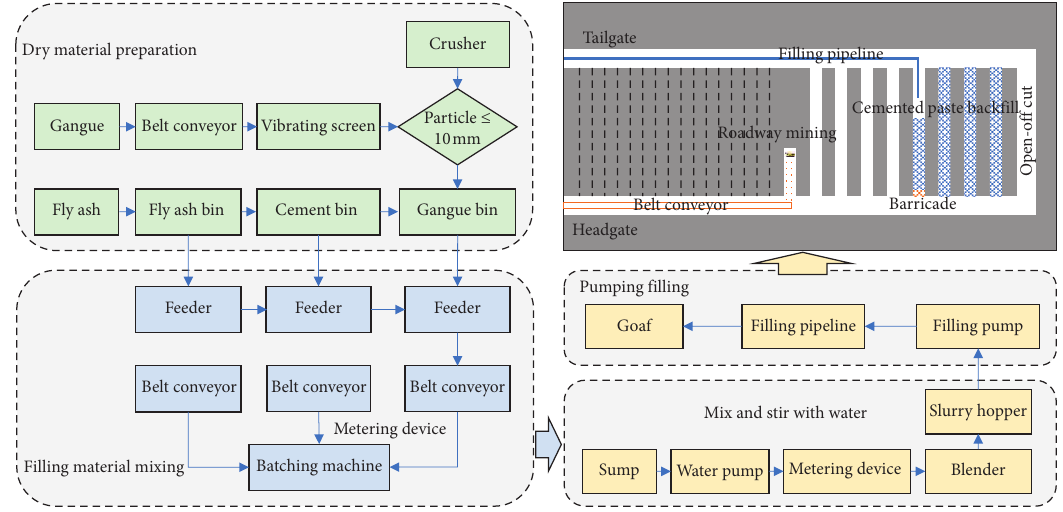
Figure 4: Technical principle and the filling process of RMCPB.